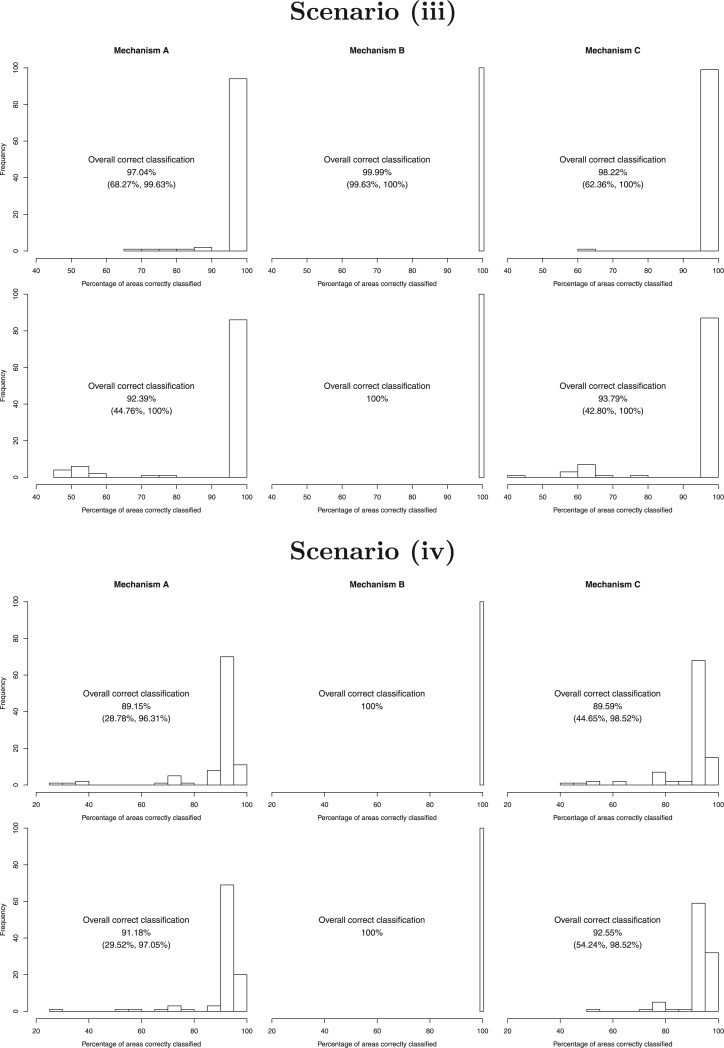
Histograms showing the percentage of areas allocated to the correct trend for each simulated data set in scenarios (iii) (top) and (iv) (bottom). In each case, the top row relates to the (MC)\documentclass[12pt]{minimal}
\usepackage{amsmath}
\usepackage{wasysym} 
\usepackage{amsfonts} 
\usepackage{amssymb} 
\usepackage{amsbsy}
\usepackage{upgreek}
\usepackage{mathrsfs}
\setlength{\oddsidemargin}{-69pt}
\begin{document}
}{}$^{3}$\end{document} algorithm, and the bottom row relates to the standard MCMC algorithm. The numbers give the overall (all 100 data sets) correct classification percentages and the lowest and highest values for a single data set.